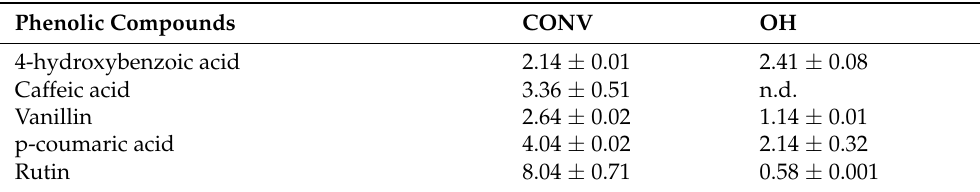
Figure 2. Total phenolics content, antioxidant capacity by ABTS, and ORAC method of free ( A ) and bound phenolics ( B ) from flour, conventional and OH extraction methods. The different letters in each methodology represent significant differences between samples ( p < 0.05). Table 6. Bound phenols complexed with tomato bagasse fibre, comparative analysis between different extraction techniques. Qualitative and quantitative analysis by HPLC.